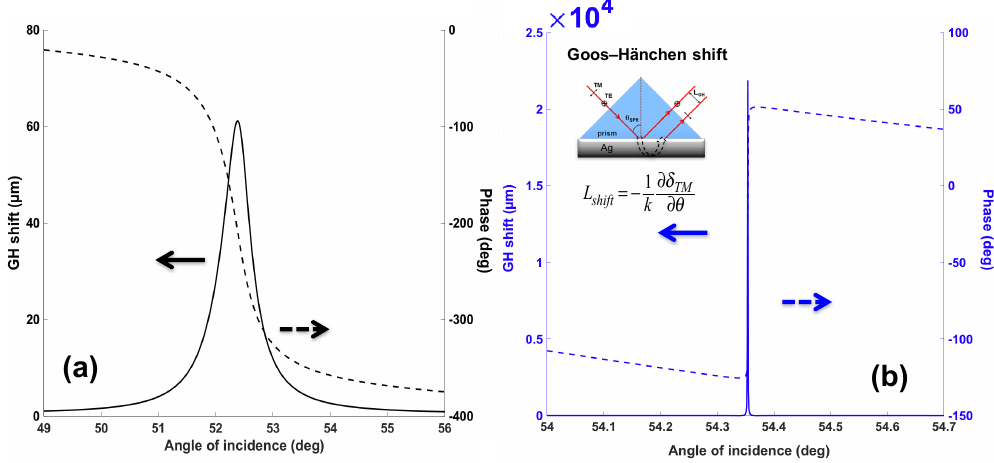
Figure 3. Comparison of Goos–Hänchen (GH) and phase signal changes with silver sensing substrate ( a ) without 2D perovskite, and ( b ) with optimized bilayer 2D perovskites (FAPbI 3